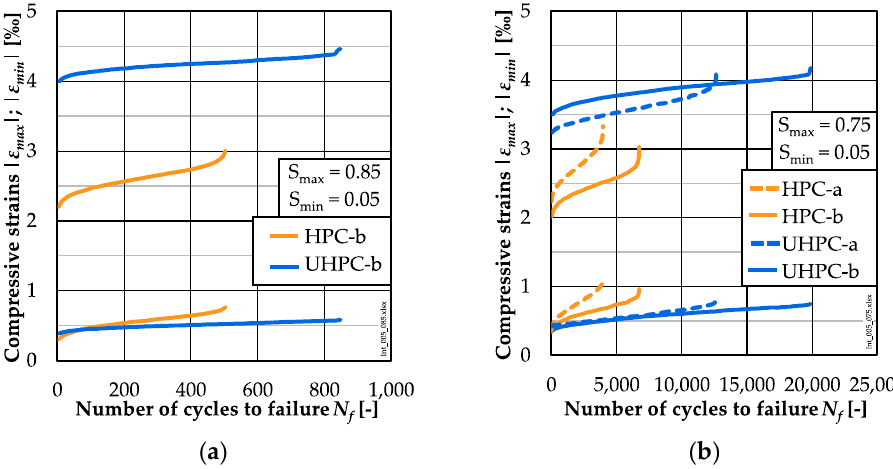
Figure 5. Averaged strain developments of HPC and UHPC at S max = 0.85 ( a ) and S max = 0.75 ( b ). The total growths of maximum and minimum strains ( ∆ε max 0 . 0 – 1 . 0 , ∆ε min 0 . 0 – 1 . 0 ) of the